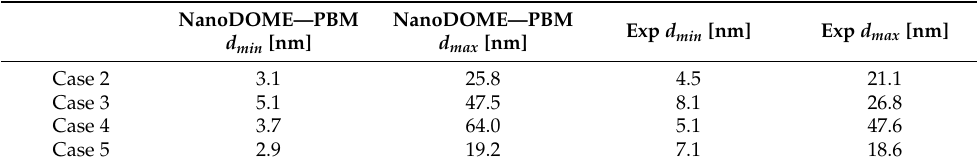
Table 3. Minimum and maximum values that define the upper and lower end of the distribution calculated by PBM or observed